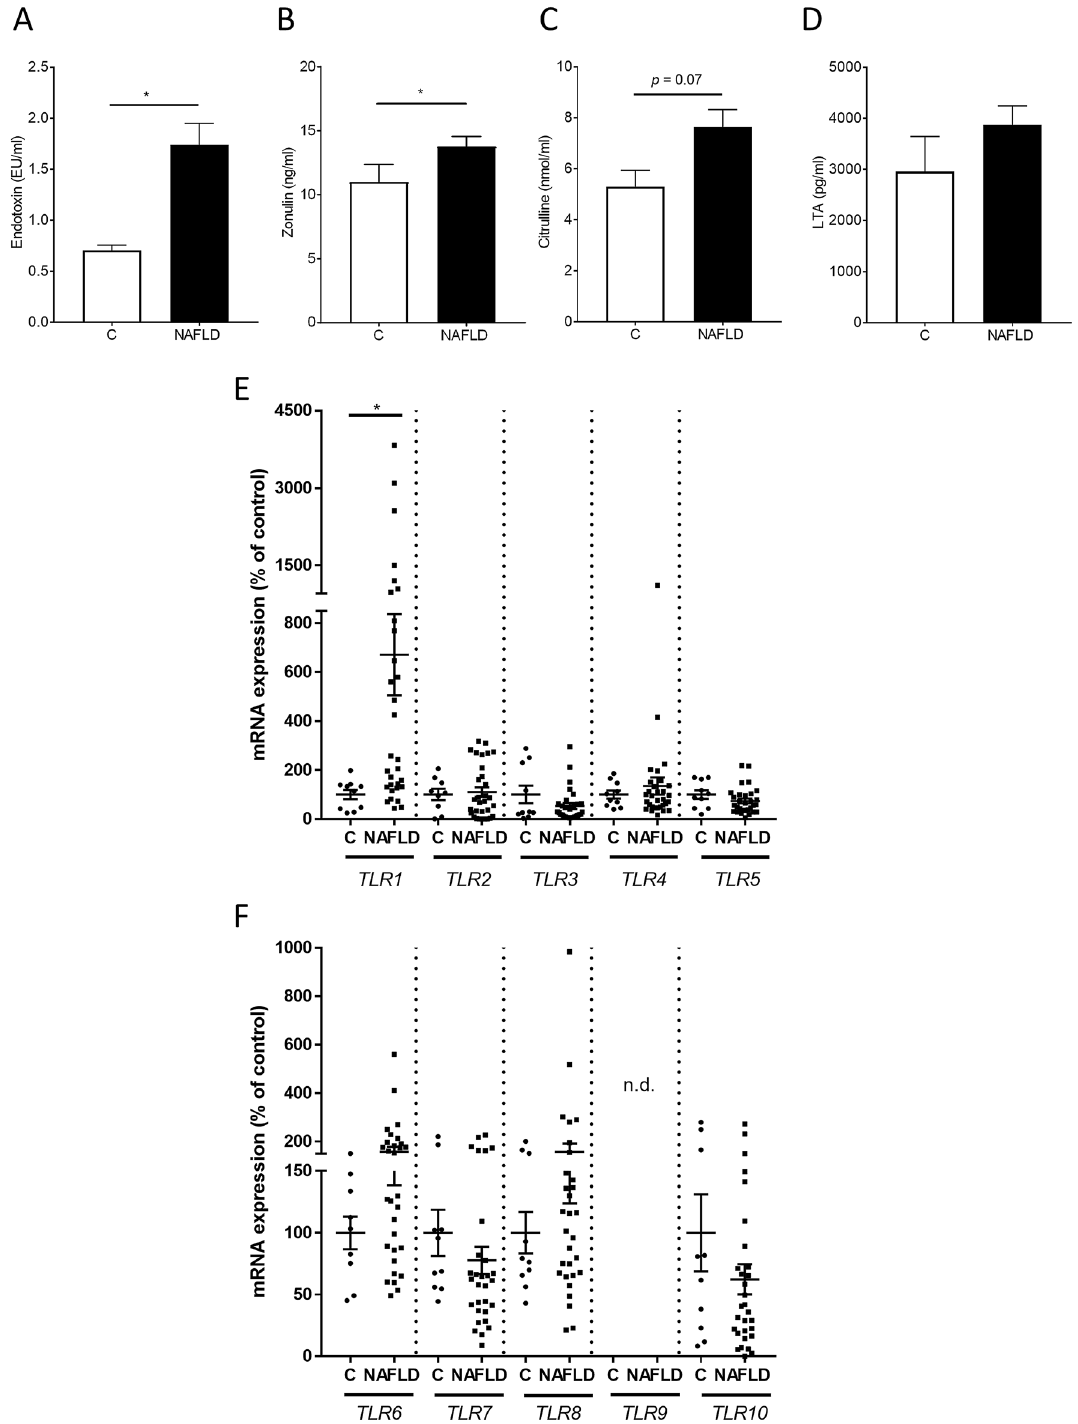
Figure 3. Markers of intestinal permeability and TLR expression in human PBMCs of NAFLD patients and controls. ( A ) Endotoxin, ( B ) zonulin, ( C ) citrulline and ( D ) lipoteichoic acid in plasma as well as ( E ) TLR1 to TLR5 and ( F ) TLR6 to TLR10 mRNA expression. Data are shown as means ± SEM, n = 10–14 controls, n = 31–36 NAFLD patients, * p ≤ 0.05. C healthy controls, LTA lipoteichoic acid, NAFLD patients with non-alcoholic fatty liver disease, PBMCs peripheral blood mononuclear cells, TLR toll-like